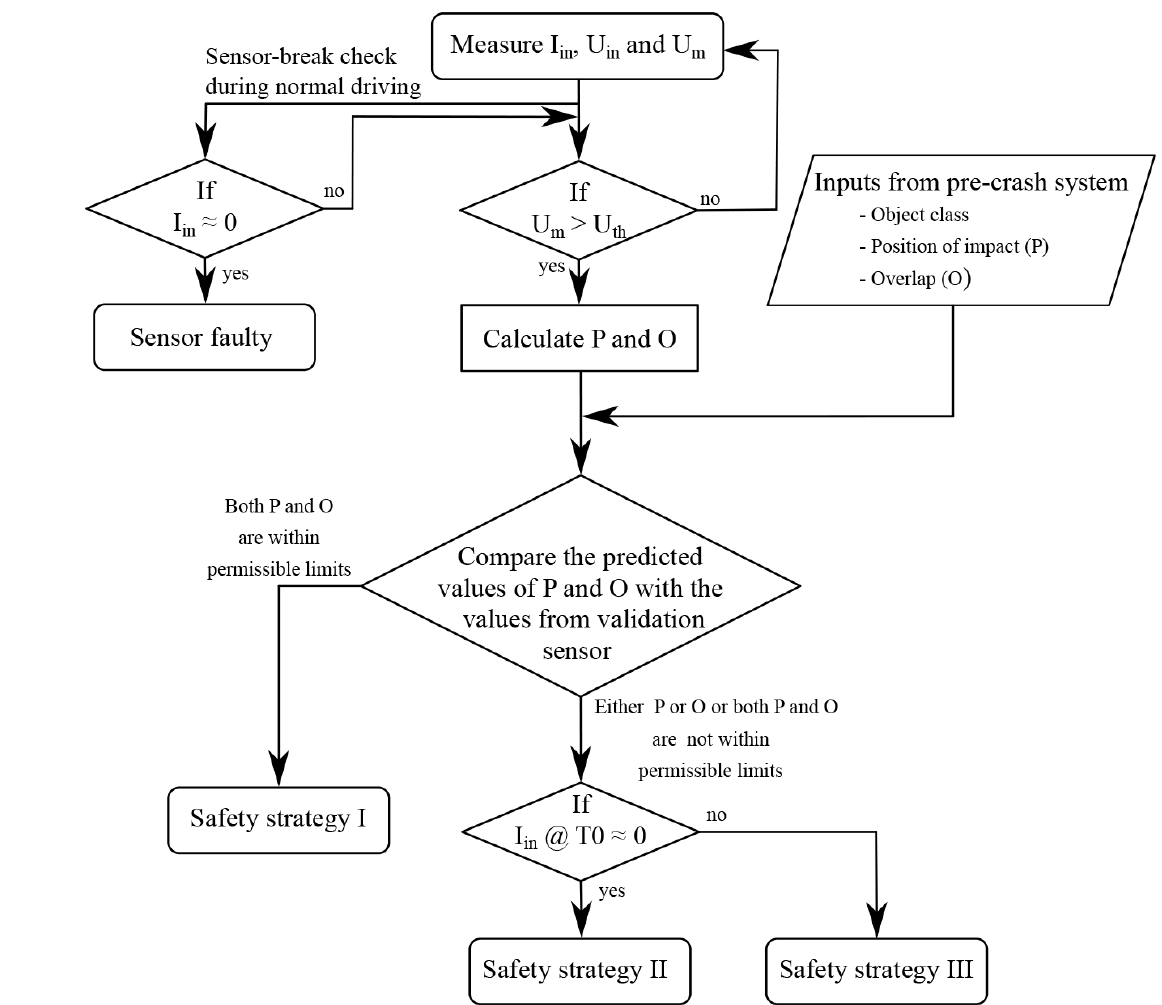
Figure 11. Generic restraint system activation